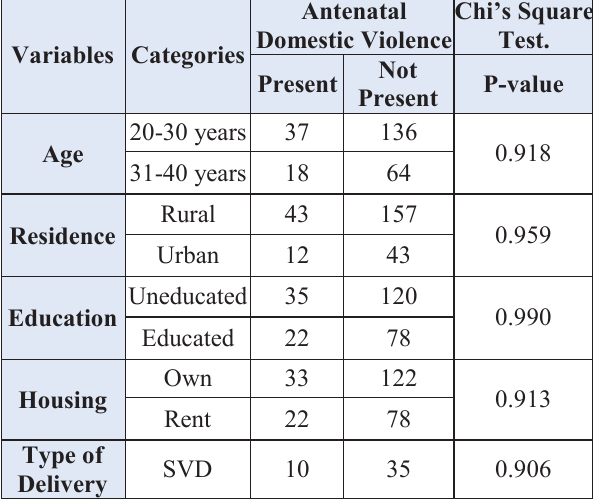
Table-2: Association of socio-demographic variables